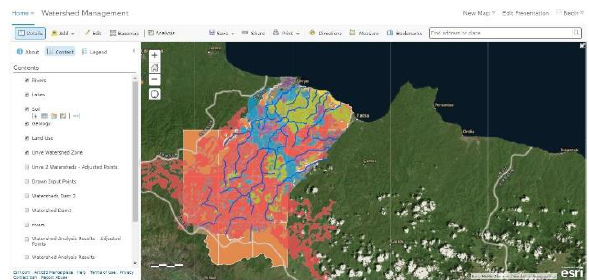
Figure 1: Study area